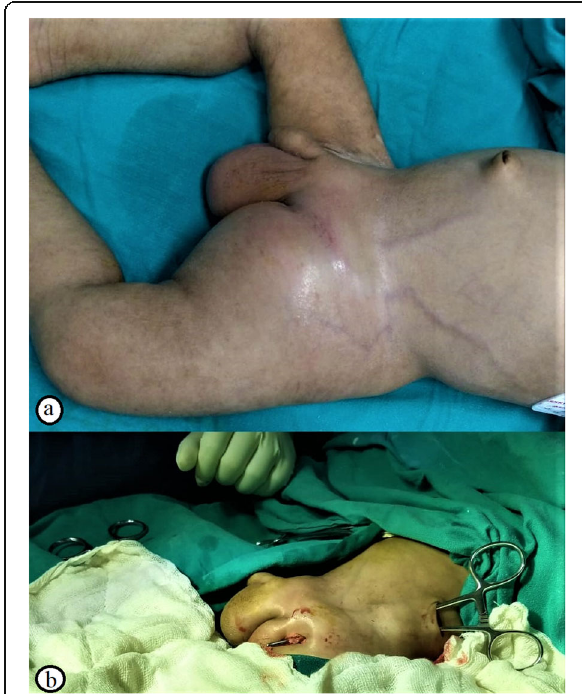
Fig. 1 a Swelling and bluish discoloration on the left thigh and groin. b Operative picture showing incision-counter incision and drainage procedure of